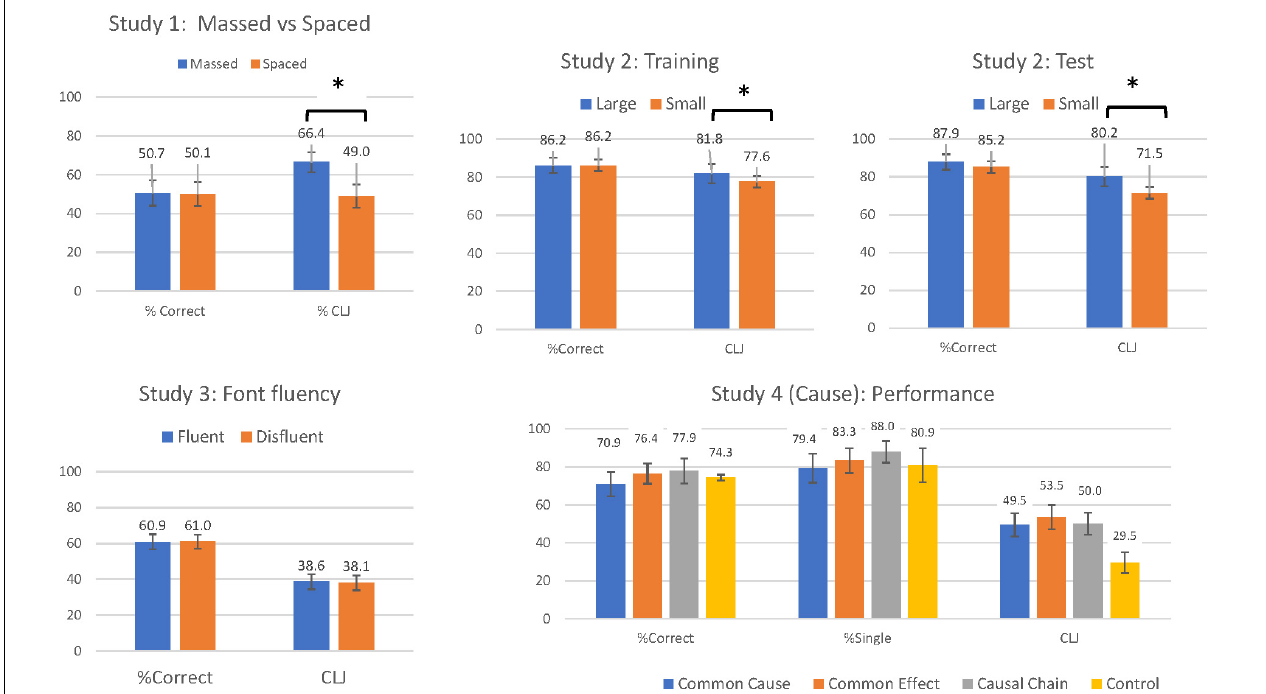
FIGURE 1 | Percent correct and estimated performance or category learning judgements (CLJ) in Studies 1–4. ∗ Significant at p <